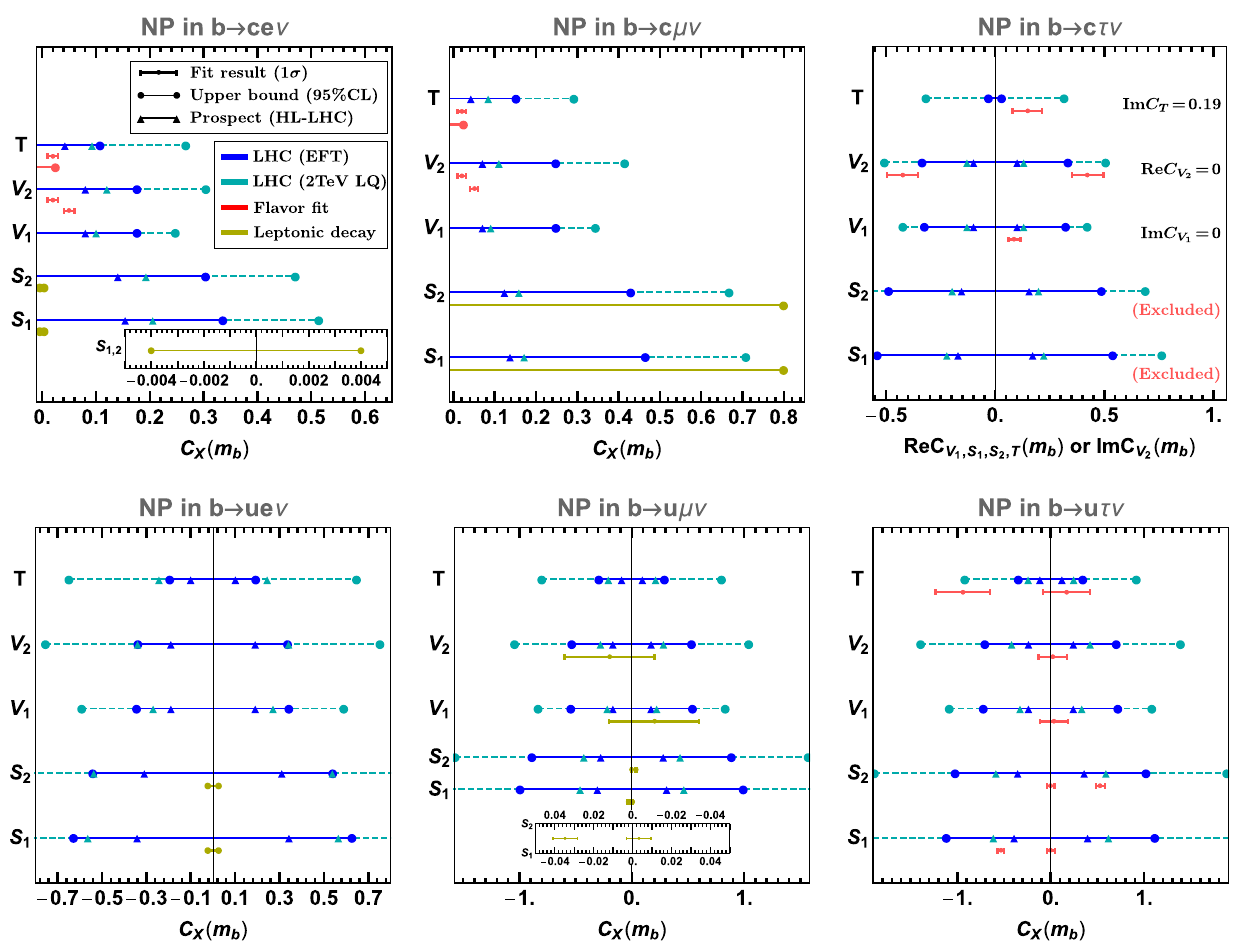
plane, the WC is taken as real. Note that the prospect for Re C c τ not be drawn since the assumption Im C c τ